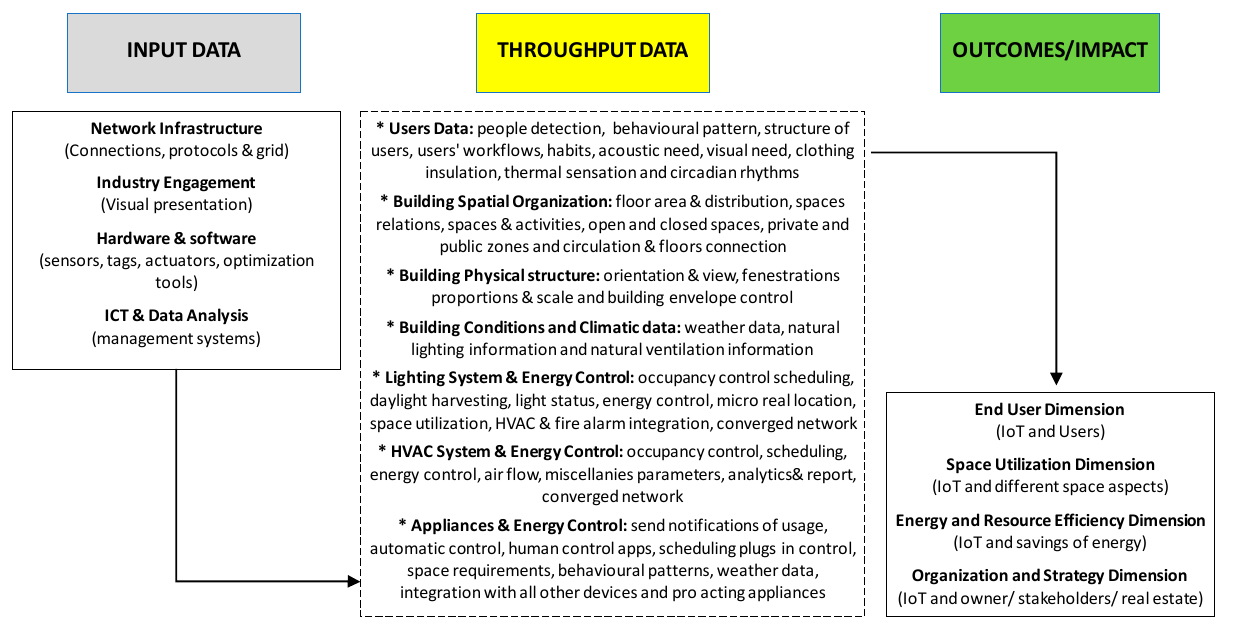
Figure 8. IoT framework domains and indicators.